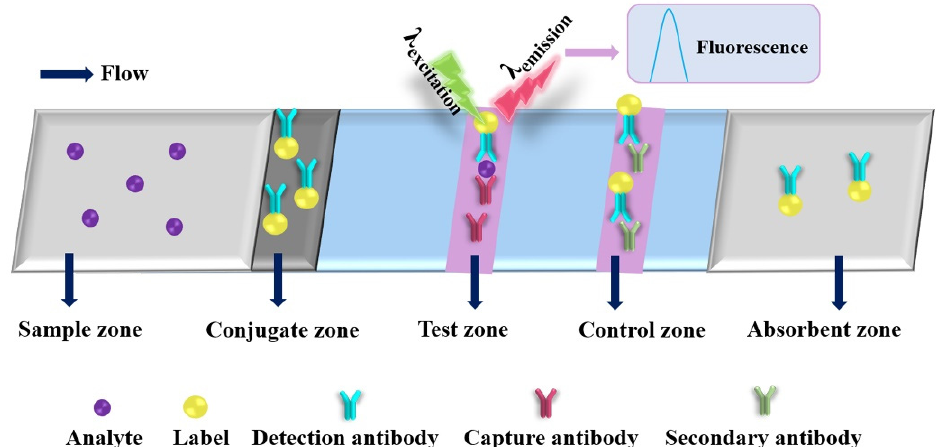
Figure 5. Schematic diagram of a typical fluorometric paper-based analytical device. Table 3. The typical nanomaterial-enhanced fluorescent PADs for sensing various analytes.